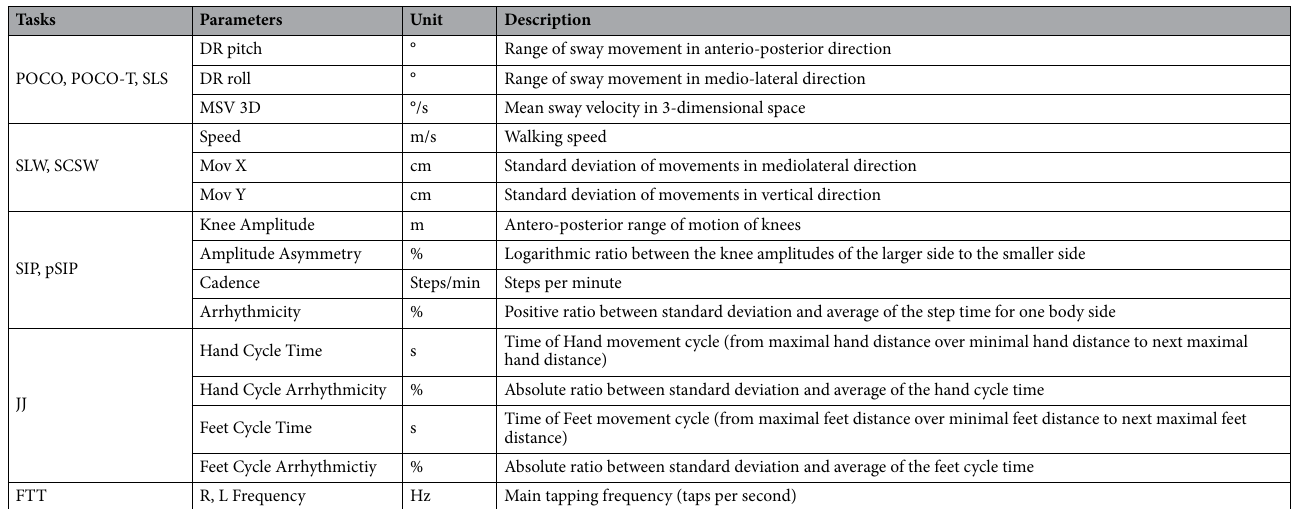
Table 2. Description of kinematic parameters to describe performance in the nine movement tasks. POCO = postural control stance, POCO-T = postural control tandem stance, SLS = single leg stance, SLW = line walk, SCSW = walk at a subjectively comfortable speed, SIP = stepping in place, pSIP = paced stepping in place, JJ = jumping jack, FTT = finger tapping test, DR = deflection range, MSV 3D = mean sway velocity in 3D,